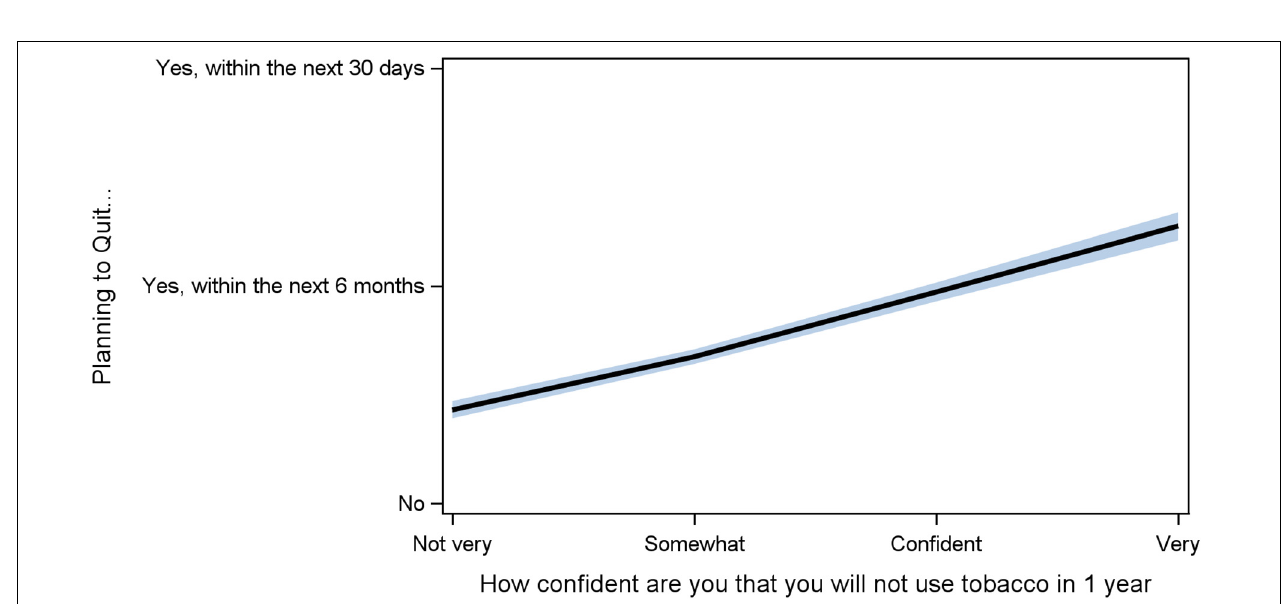
FIGURE 1 | Association between perception of inherent (implicit) ability to quit and planning to quit. The Y -axis is planning to quit (Not, within 6 months, with 30 days). The X -axis is the level of belief in the patient’s implicit ability to quit (0–4: not at all, a little, somewhat, mostly, completely). The black line is the fitted slope for responses. The blue shadow is the 95% confidence band.